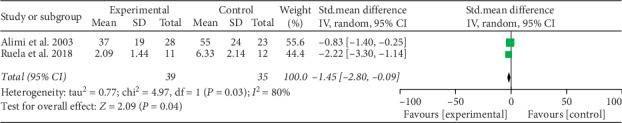
Forest plot of auricular therapy for the treatment of cancer pain compared with sham auricular therapy.